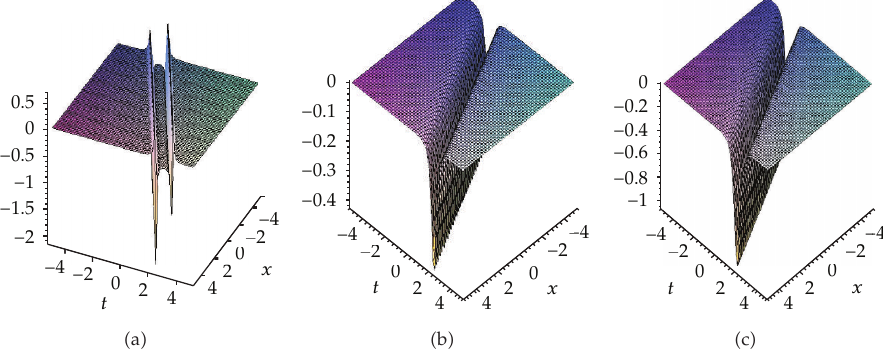
Figure 3: Evolutional behaviour of u 1 describes dark soliton: (cid:3) a (cid:4) p (cid:7) 1 / 32 , q (cid:7) 1; (cid:3) singular wave solution (cid:4) ; (cid:3) b (cid:4) p (cid:7) 3 , q (cid:7) 1; (cid:3) c (cid:4) p (cid:7) 27 , q (cid:7)